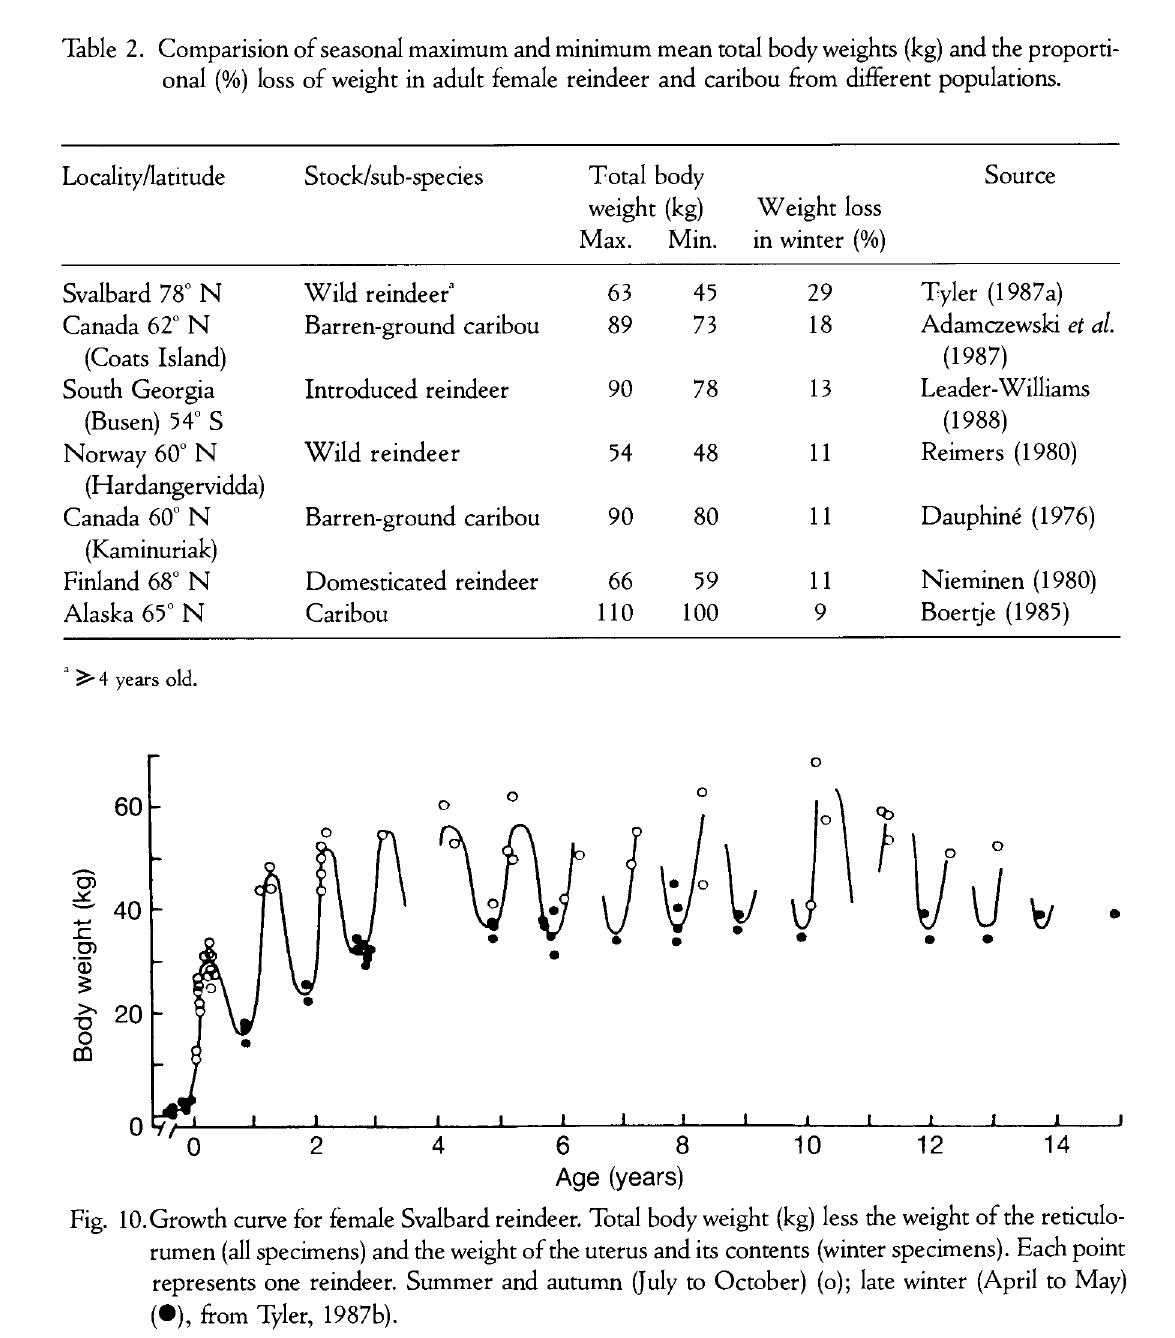
Table 2. Comparision of seasonal maximum and minimum mean total body weights (kg) and the proporti onal (%) loss of weight in adult female reindeer and caribou from different populations.